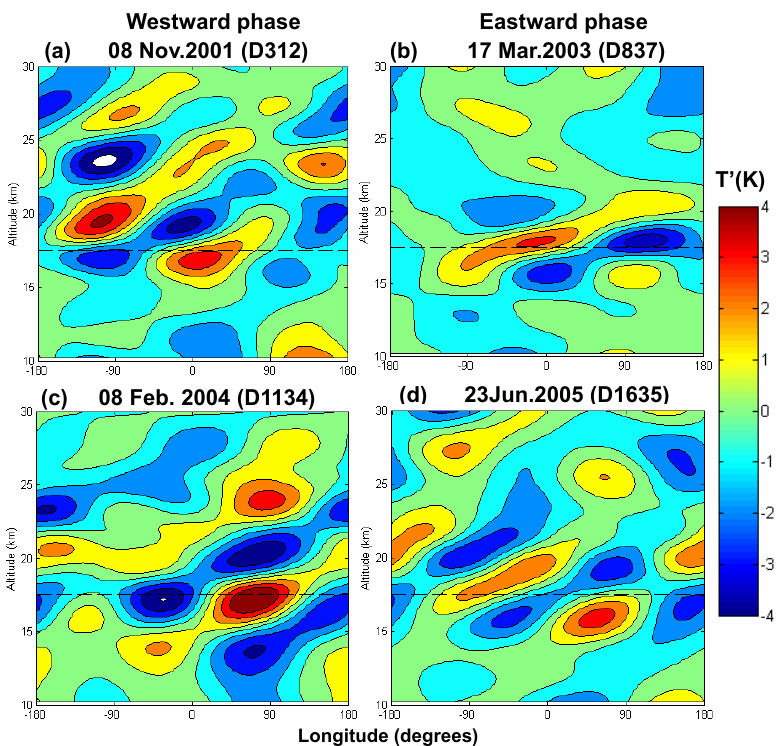
Fig. 6. Examples showing the altitude-longitude sections of fitted T s observed in westward (left panels) and eastward (right panels) phases Figure 6. Examples showing the altitude-longitude sections of fitted Ts’ observed in westward of QBO during the periods shown with vertical lines in Fig. 1a. Note that ± 1-day observations are considered to the day/ day number (from (left panels) and eastward (right panels) phases of QBO during the periods shown with 1 January 2001) mentioned on the top of each vertical lines in fig. 1(a). Note that ± 1 day observations are considered to the day/ day number (from January 01, 2001) mentioned on the top of each panel.